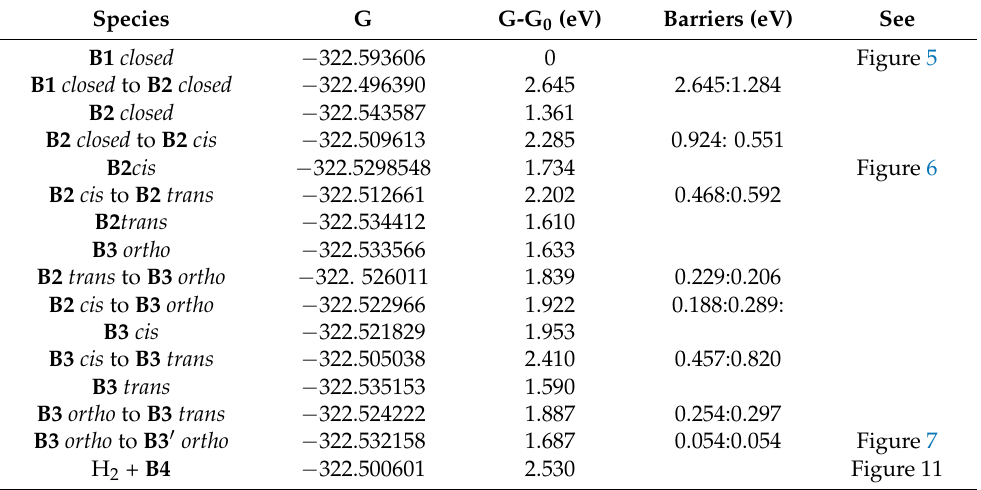
Table 1. Energetics ( ω B97XD/def2-tzvp) for landmarks along the B path for H transfer to polycyclic Os species from the most stable species, the C 6v complex of Os cation with benzene, OsC 6 H 6+ . This is called B1 closed . Species labels and Gibbs energies (G) in Hartrees are reported along with relative Gibbs energies, G–G 0, in electron volts (eV). The Gibbs energy for B1 closed is the reference point (0).